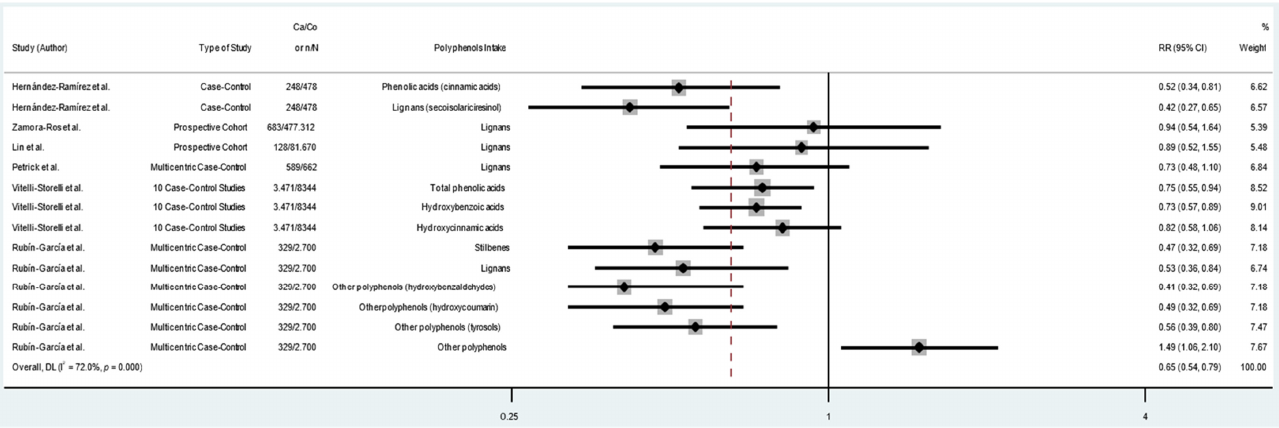
Figure 5. Forest plot of consumption of lignans, phenolic acids, stilbenes, and other polyphenols and gastric cancer risk. Case–control and cohort studies are presented in chronological order of publication. Square boxes represent study-specific estimates. Markers vary in size according to weight assigned to each study, size of each box reflects the study’s weight in the analysis, and horizontal lines represent 95% confidence intervals. Diamonds show the pooled effect. Abbreviations: RR, relative risk; Ca, number of cases; Co, number of controls; n, number of events; N, number of patients [4,5,15,1,25,27,28].